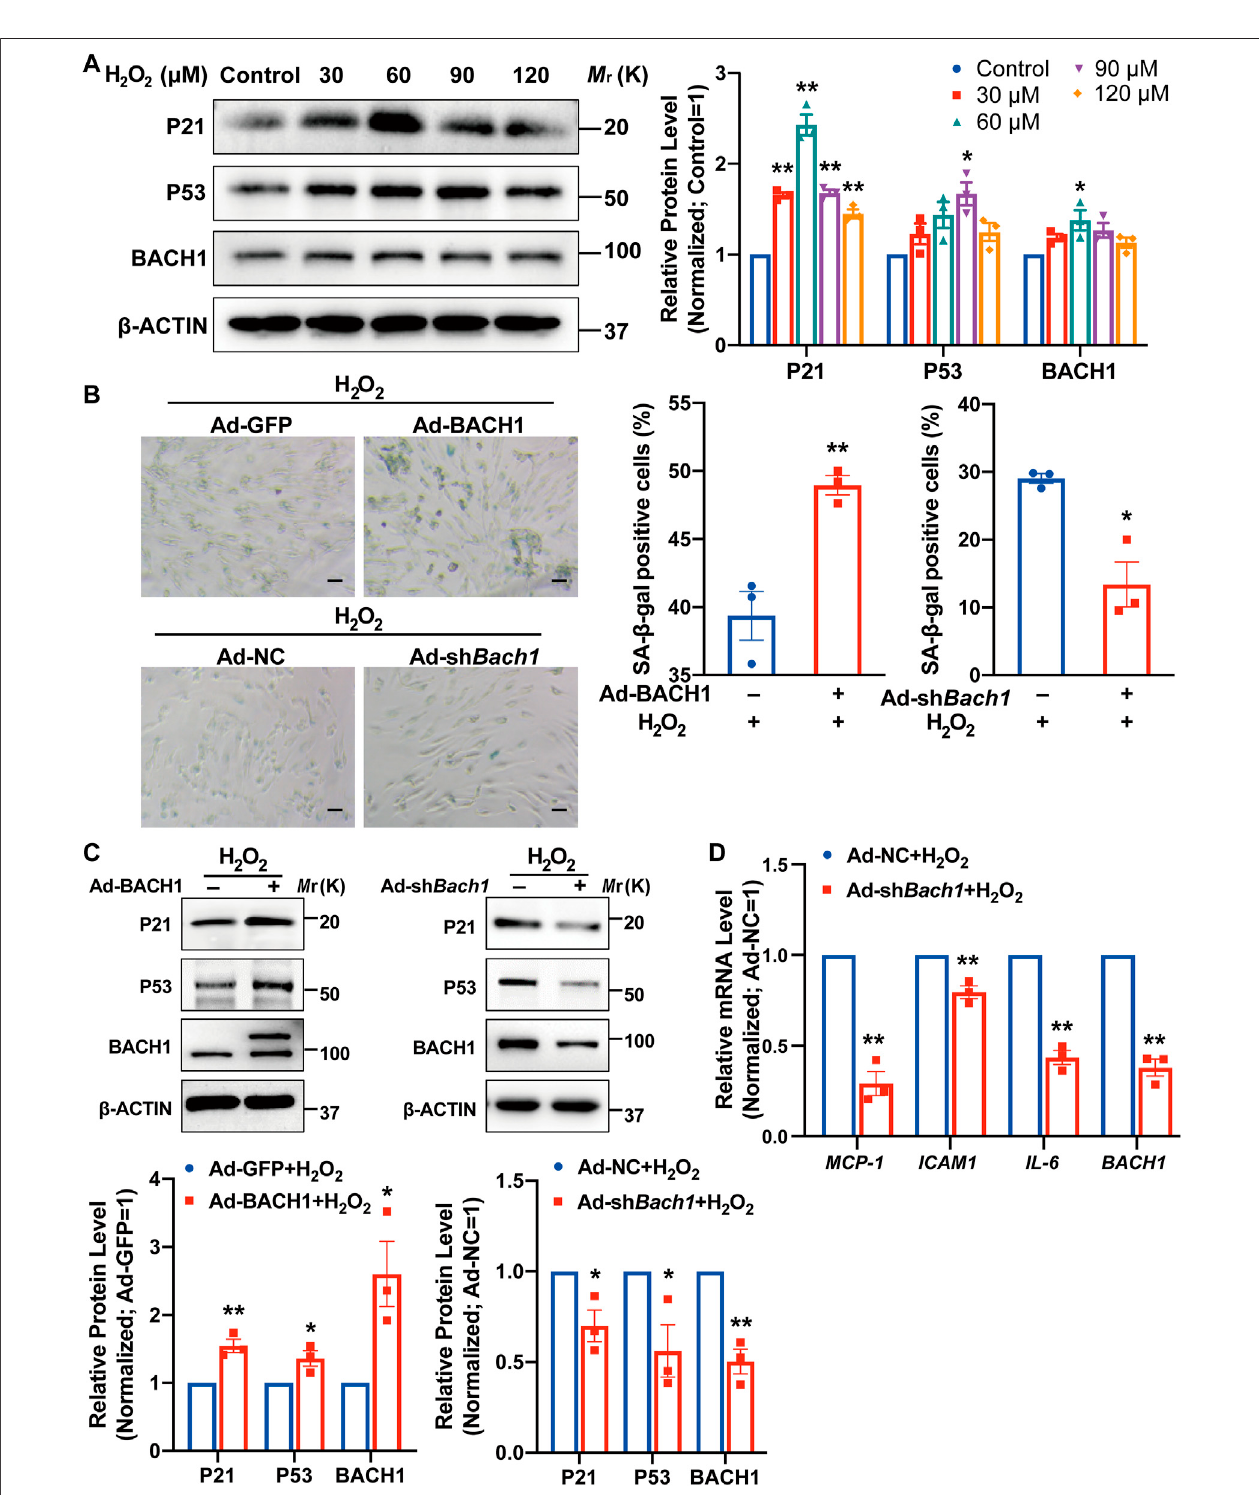
FIGURE 5 | BACH1 aggravates endothelial cell senescence under oxidative stress. (A) Western blot analysis of P21, P53, and BACH1 protein levels in HUVECs underH 2 O 2 (0,30,60,90,120 μ M) treatment for12 h.Quantitativeanalysiswasnormalized tocontrol( n (cid:2) 3independent experiments, dataaremean ± SEM.One-way ANOVAfollowed by Tukey post-hoc tests, * p < 0.05 versusControl, ** p < 0.01 versusControl). (B) RepresentativeimagesofSA- β -gal staining forHUVECs under H 2 O 2 (60 or 120 μ M) treatment for 12 h after BACH1 overexpression or knockdown via adenovirus infection. Scale bar, 50 μ m. Quantitative analysis was measured by thepercentageofSA- β -galpositivecells( n (cid:2) 3independentexperiments,dataaremean ± SEM,unpaired2-tailed t -test,* p < 0.05,** p < 0.01). (C) Westernblotanalysis